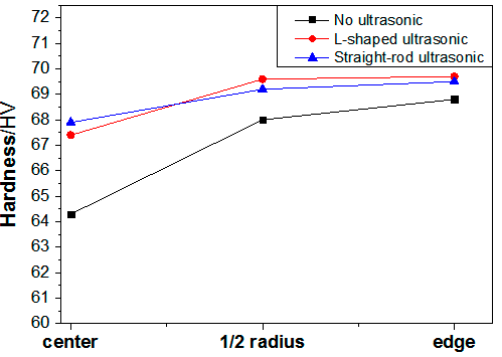
Figure 12. Hardness test results along the radial direction of the ingots under different processing